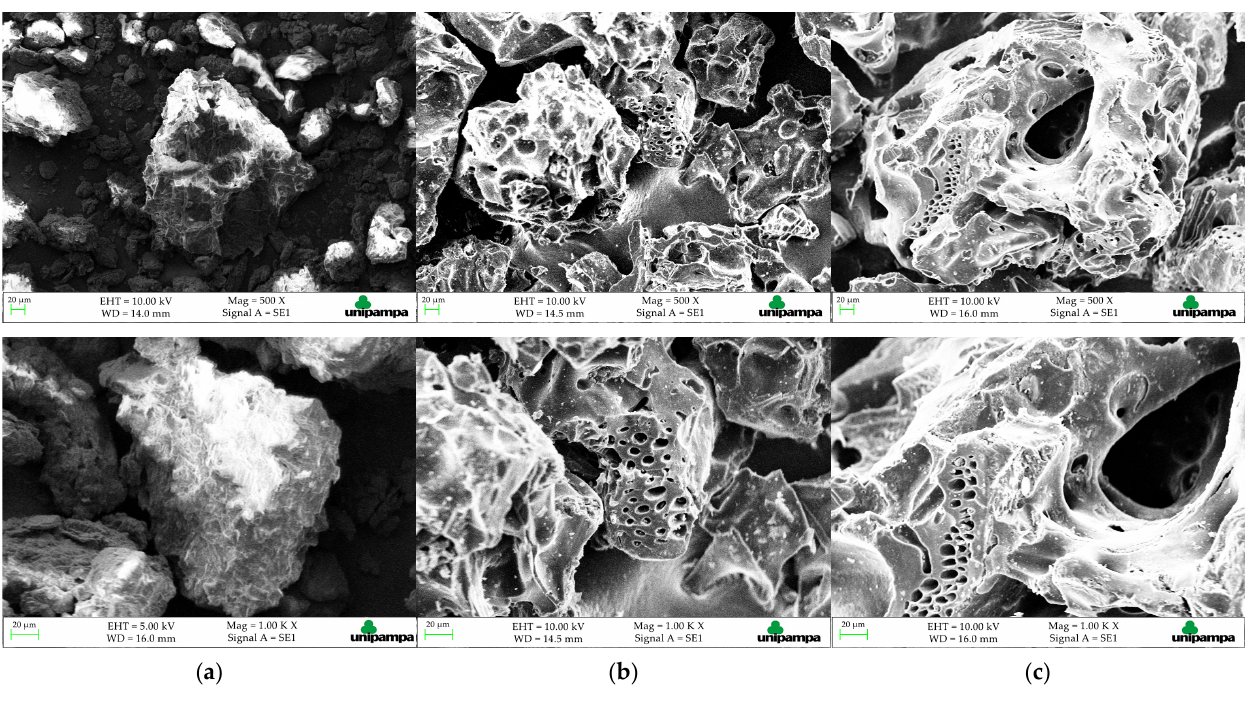
Figure 9. SEM images: ( a ) OP, ( b ) ACOP and ( c ) ACOPN.